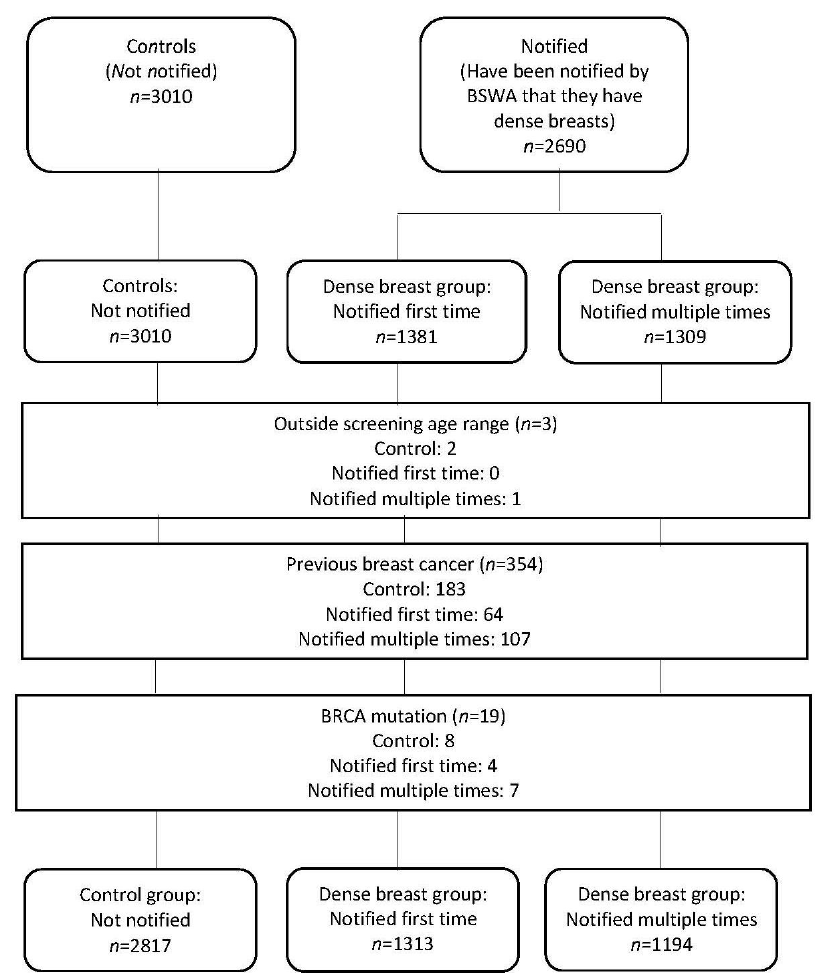
Figure 1. Flowchart of breast density survey respondents.